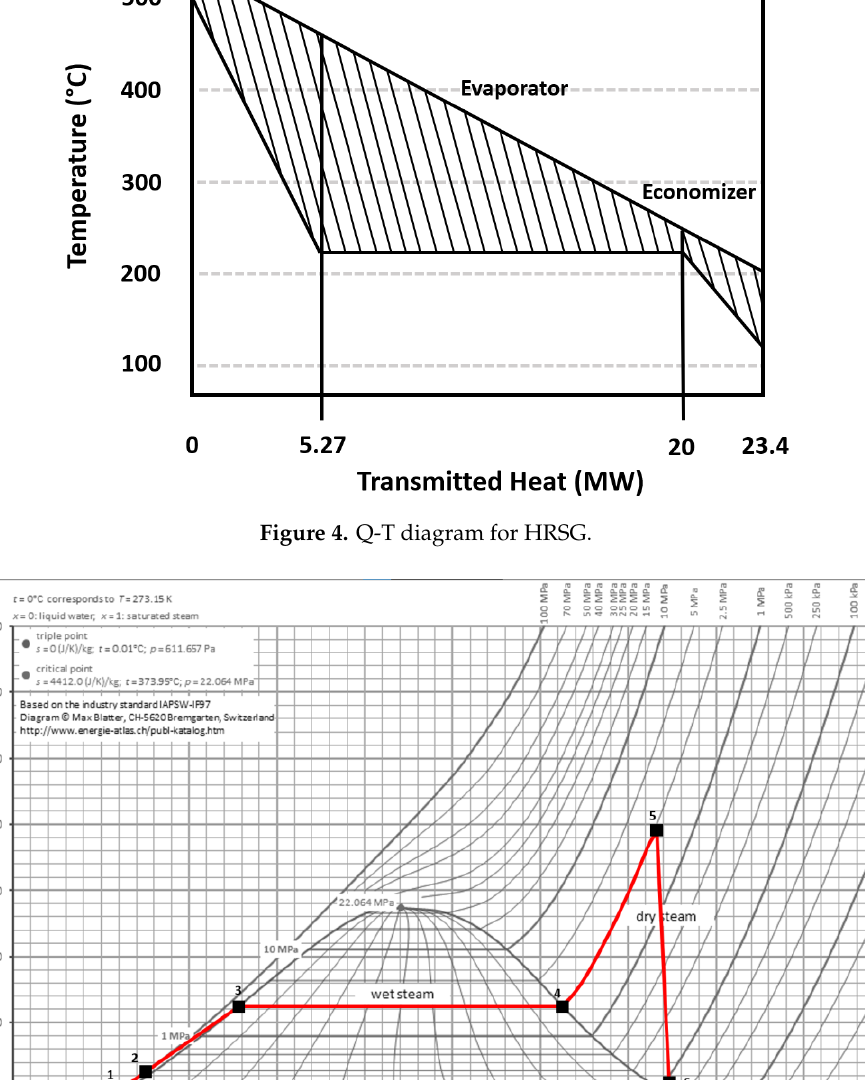
Figure 4. Q-T diagram for HRSG.